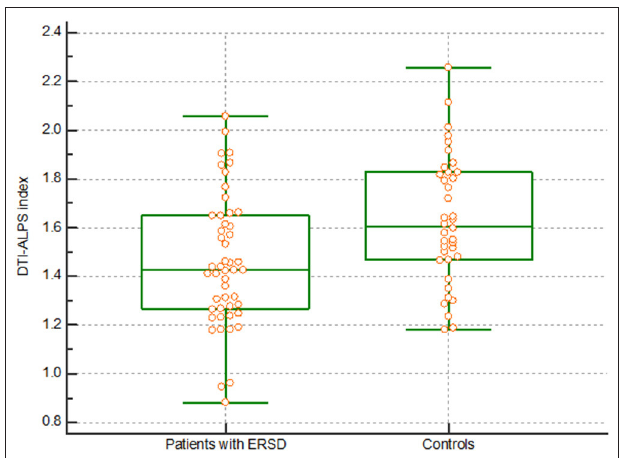
FIGURE 1 | DTI-ALPS index. The graph shows a significantly lower DTI-ALPS index in patients with ESRD than in healthy controls. DTI-ALPS, diffusion tensor image analysis along with the perivascular space; ESRD, end-stage renal disease.